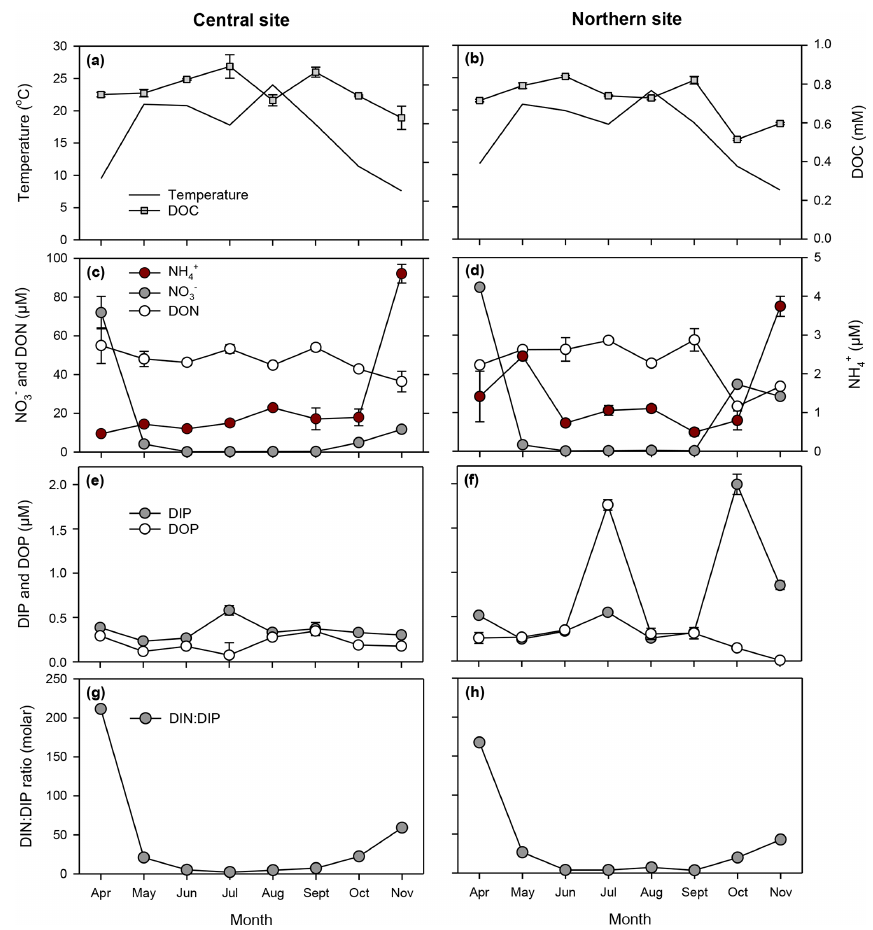
Figure 4. Temporal patterns in temperature, dissolved organic carbon (a, b) , dissolved inorganic and organic nitrogen (c, e) , phosphorus (e, f) , and DIN : DIP ratios (g, h) at central (surface layer; left panels) and northern (right panels) sites in the Curonian Lagoon during 2018 (error bars denote standard error based on three replicates; some are not